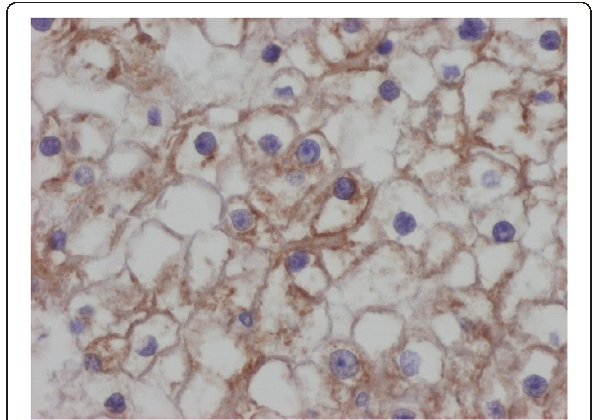
Figure 7 Positivity of RCC for the HLA-G, immunohistochemistry, DAB method, clone MEM-G/1, Exbio Prague. Analysed by Olympus BX45 microscope equipped with Olympus DP50 digital camera. Olympus Viewfinder Lite ™ software was used to acquire and process the image, 400×.